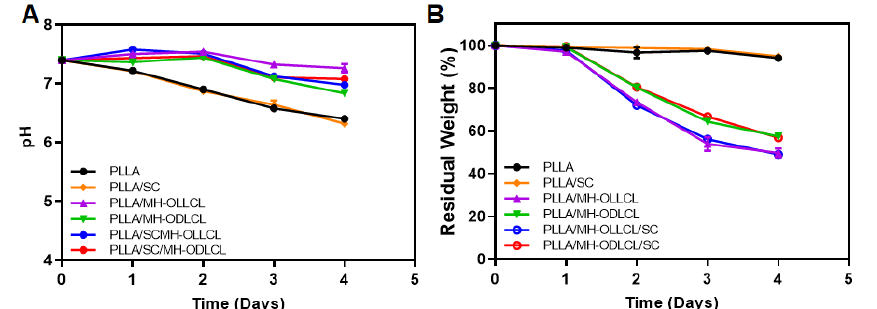
Figure 6. Changes in ( A ) pH value and ( B ) residual weight during degradation in PBS solution with proteinase K at 37 °C over 4 days for the PLLA, PLLA/SC, PLLA/MH − OLLCL, PLLA/MH − ODLCL, PLLA/SC/MH − OLLCL, and PLLA/SC/MH − ODLCL composites.